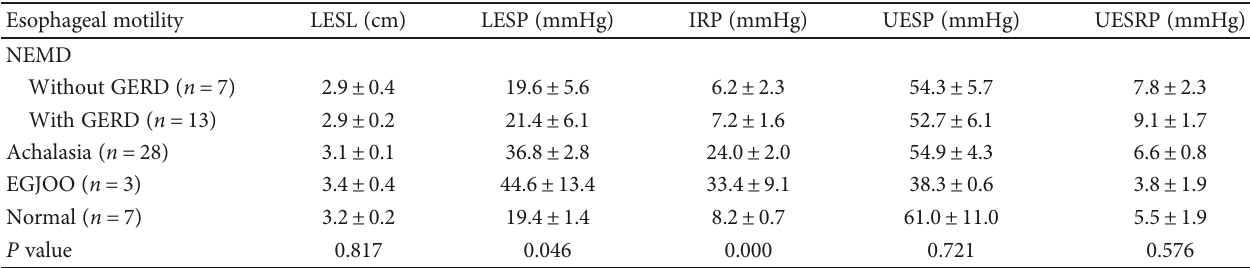
Table 1: Results of esophageal manometry in 58 NOD patients — LES and